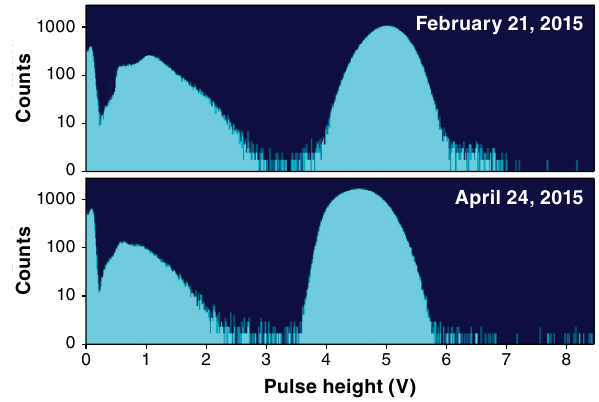
FIG. 15. Pulse height spectra screen shots obtained with the pulse-height analyzer software [30]. The logarithm of counting rates is displayed as a function of pulse heights. The peaks to the right were obtained using identical settings of a precision light pulse generator. The slight shift of this peak indicates a ∼ 12 % light transmission loss due perhaps to slight radiation damage of the 1.2 m long light guide or of the fiber carrying the light signal to the far end of the light guide.